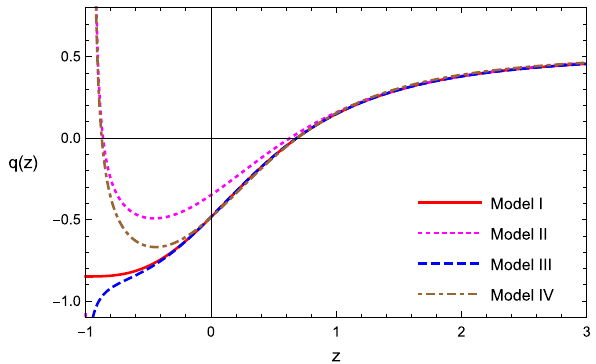
Fig. 4 It shows the deceleration parameter q ( z ) vs z